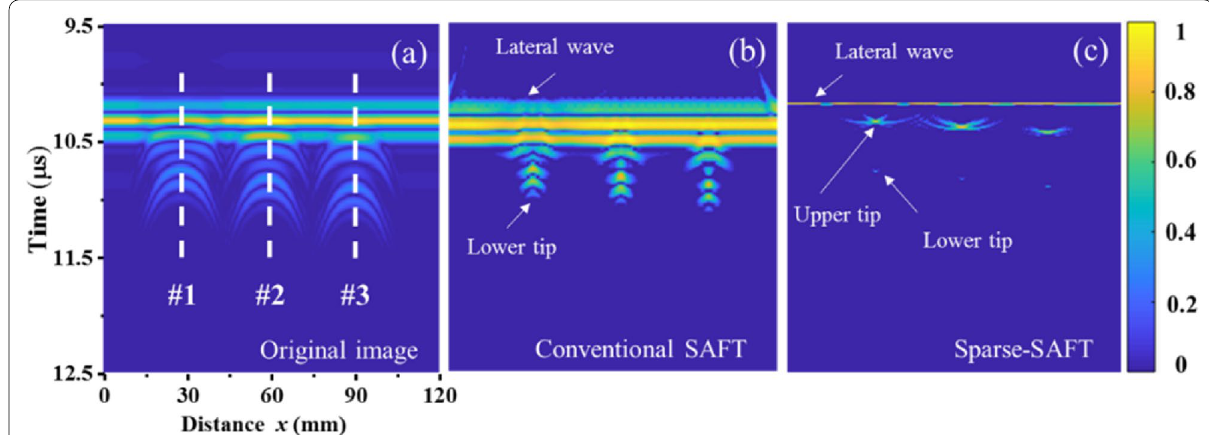
Figure 4 Original image and reconstructed images by simulation: ( a ) original B-scan image, ( b ) reconstructed image by conventional SAFT, ( c ) reconstructed image by Sparse-SAFT